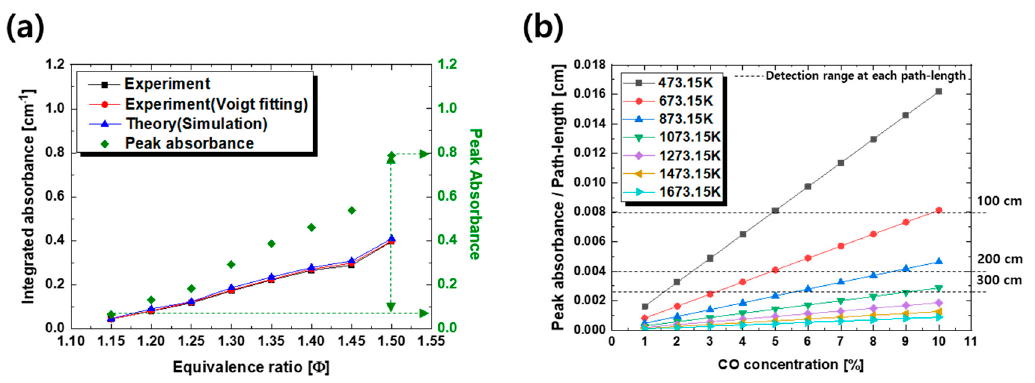
Figure 6. ( a ) Comparison of the experimentally obtained integrated absorbance with that calculated through Voigt simulation for the analysis of the detection limit in the combustion environment. ( b ) Simulation results of detection limit range according to various temperature and CO concentration conditions at 1 atm.